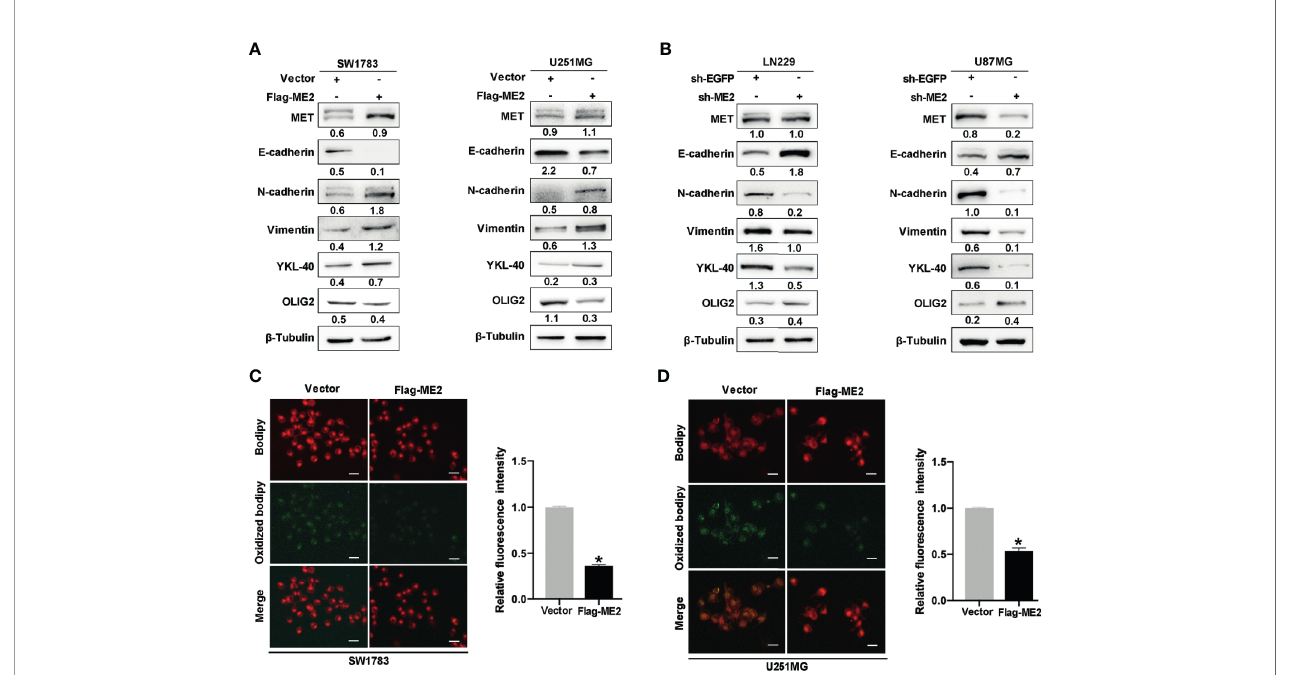
FIGURE 7 | ME2 promotes PMT and inhibits the production of ROS in mitochondria. (A, B) Western blots con fi rming the expression of MET, E-cadherin, N-cadherin, vimentin, YKL-40, and OLIG2 (A) in SW1783 and U251MG cells transfected with vector or Flag-ME2 plasmids and (B) in LN229 and U87MG cells transfected with sh-EGFP or sh-ME2 plasmids. (C, D) Changes in ROS in mitochondria of SW1783 and U251MG cells transfected with vector or Flag-ME2 plasmids detected by fl uorescent probe. Green fl uorescence represents lipid components oxidized by ROS; red fl uorescence represents nonoxidized lipid components. Fluorescence intensity statistics and analysis by Image J (*P <